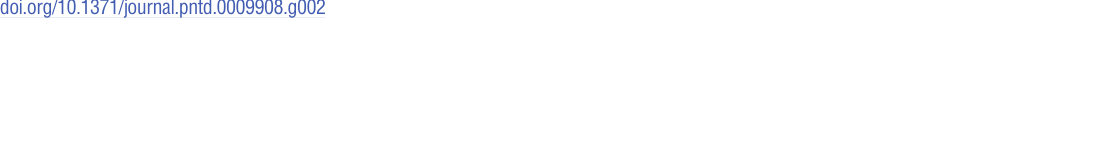
PLOS NeglectedTropical Diseases | https://doi.org/10.1371/journal.pntd.0009908 December9, 2021 14 /